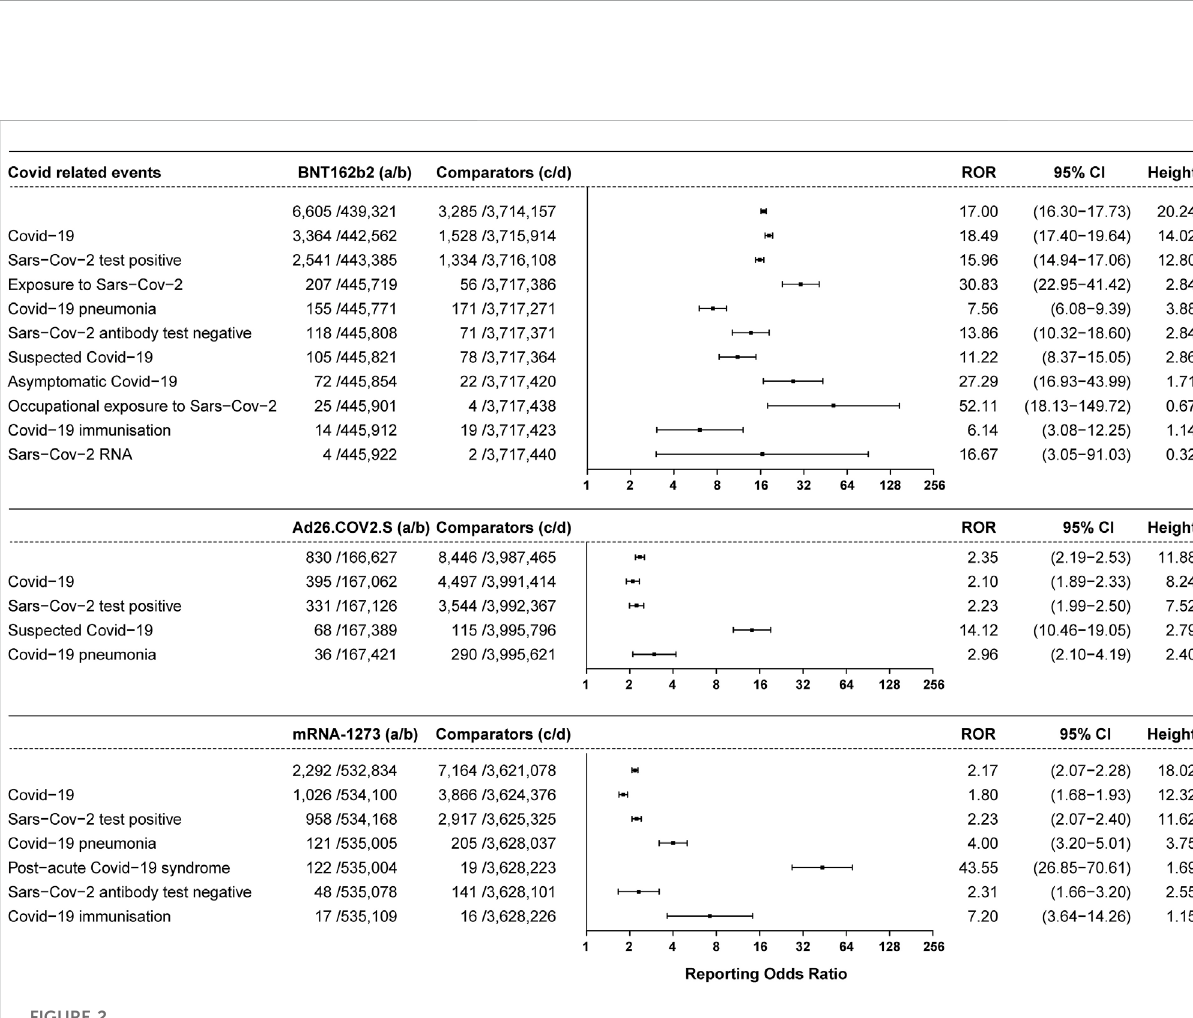
FIGURE 2 ROR values and height of the COVID-19 vaccines of BNT162b2-, Ad26.COV2.S-, and mRNA-1273-associated COVID events. a: cases of target COVID events reported concerning the target COVID-19 vaccines; b: cases of other AEFI reported concerning the target COVID-19 vaccines; c: cases of target COVID events reported concerning all the other vaccines; d: cases of other AEFI reported concerning all the other